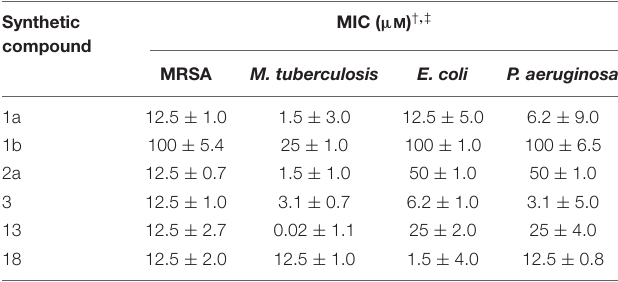
TABLE 2 | Anti-bacterial activity of synthetic compounds against MRSA, P. aeruginosa , E. coli , and M. tuberculosis